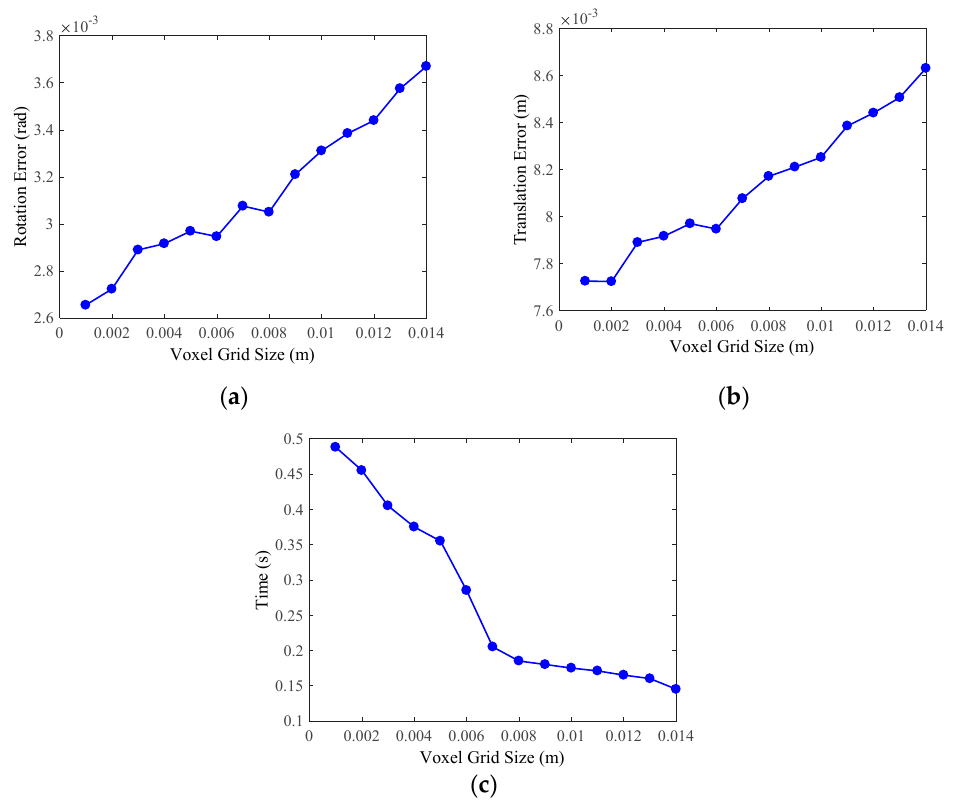
Figure 10. Evaluation results of the VoxelGrid downsampling method. We set the voxel grid size as the abscissa, and the evaluation was conducted on 20 point clouds that are processed by the statistical outlier removal method. ( a ) The rotation matrix errors of point cloud registration by using ICP. ( b ) The translation errors of point cloud registration by using ICP. ( c ) The runtime of VoxelGrid downsampling.